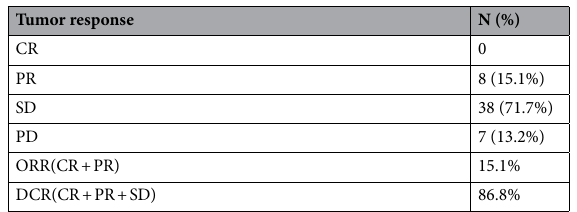
Table 2. Objective response rate (ORR) and disease control rate (DCR) of apatinib in recurrent/metastatic inoperable head and neck squamous cell carcinoma patients. Responses were graded using the RECIST criteria